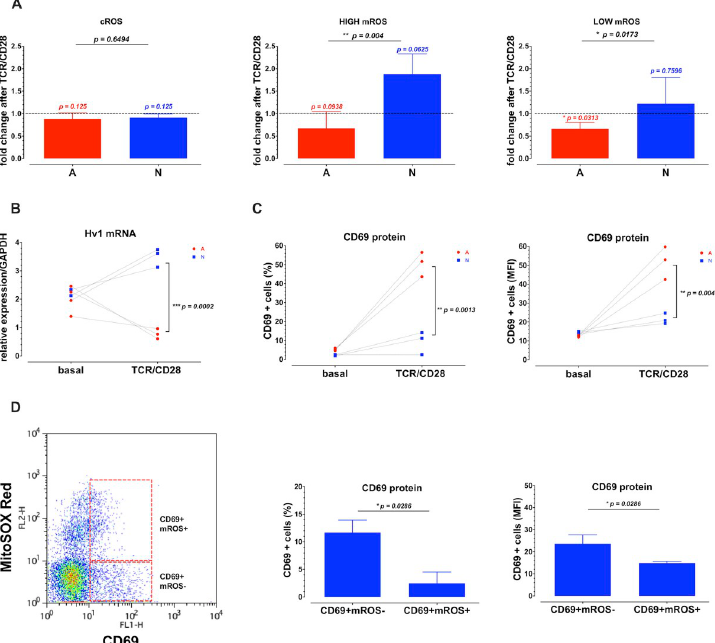
Fig 2. The initial redox stress impairs the activation of neonatal human CD8 + T cells upon TCR/CD28 stimulation. Purified human CD8 + T lymphocytes from neonate (N) or adult (A) donors were stimulated with anti- CD3/anti-CD28 antibodies. After 6 hours, the cells were collected for measurements. For the ROS evaluation, cells were incubated with 2 μ M of DHE or 2.5 μ M of the MitoSOX Red (A) fluorescent dyes for 15 minutes. The fluorescence of the cells was assessed using a FACScalibur Flow Cytometer. The graphs show the fluorescence or frequency of the cells after normalization to the basal levels of a total of 5 and 6 neonatal and adult cells’ samples, respectively. (B) Total RNA was extracted from untreated or TCR/CD28 stimulated cells, using the TRIzol reagent. The Hv1 proton channel mRNA levels were evaluated using specific primers on a qPCR using the GAPDH mRNA levels as a reference gene. During our measurements, (C) The cells were washed and incubated with an anti-CD69 FITC fluorescent antibody for 30 mins the fluorescence or frequency of the cells was analyzed using a FACScalibur Flow Cytometer. (D) A MitoSOX Red and anti-CD69 FITC double staining was performed on CD8 + T cells from neonates. The fluorescence or the frequencies of CD69 + mROS - and CD69 + mROS + populations is represented on the bar graphs. An unpaired Mann-Whitney test was used for comparisons between samples from neonatal (N) and adult (A) cells, considering four samples per group. The p-values between the bars denote the significance between adult and neonatal cells. On top of each bar, we show the significance between paired samples of stimulated N or A groups as compared with the non-stimulated cells. A Wilcoxon test was used for these comparisons.